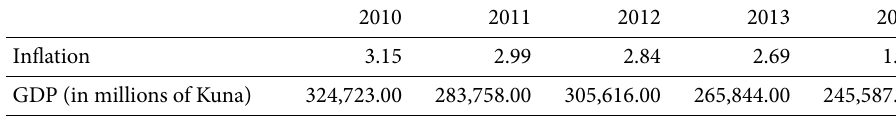
table 6. Scenario of the reduction in the level of inflation and the impact on GDp